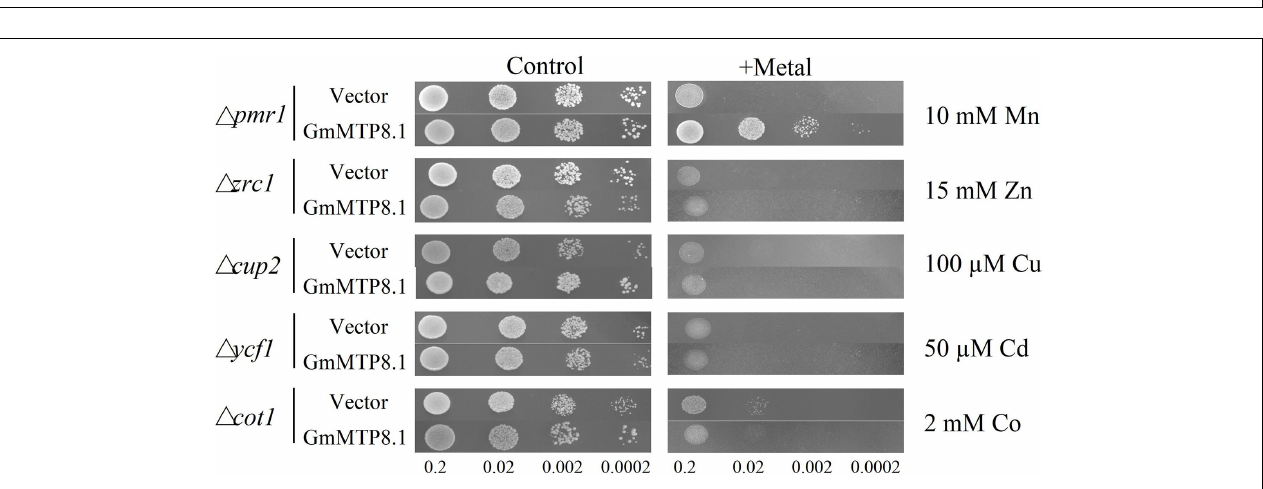
FIGURE 6 | Subcellular localization of GmMTP8.1 in tobacco leaf lower epidermal cells. The images are labeled to show the 35S:GFP and 35S:GFP-GmMTP8.1 constructs. 35S:GFP-GmMTP8.1 was co-expressed with the (A) tonoplast marker TPK1 and (B) endoplasmic reticulum marker PIN5 fused with red fluorescence protein (mKATE) in tobacco leaf epidermal cells. green fluorescent protein (GFP) fluorescence, red fluorescent protein (RFP) fluorescence, chloroplast autofluorescence, bright field images, and merged images are displayed from left to right. Fluorescence was observed by confocal microscopy. Scale bar is 20 µ m.